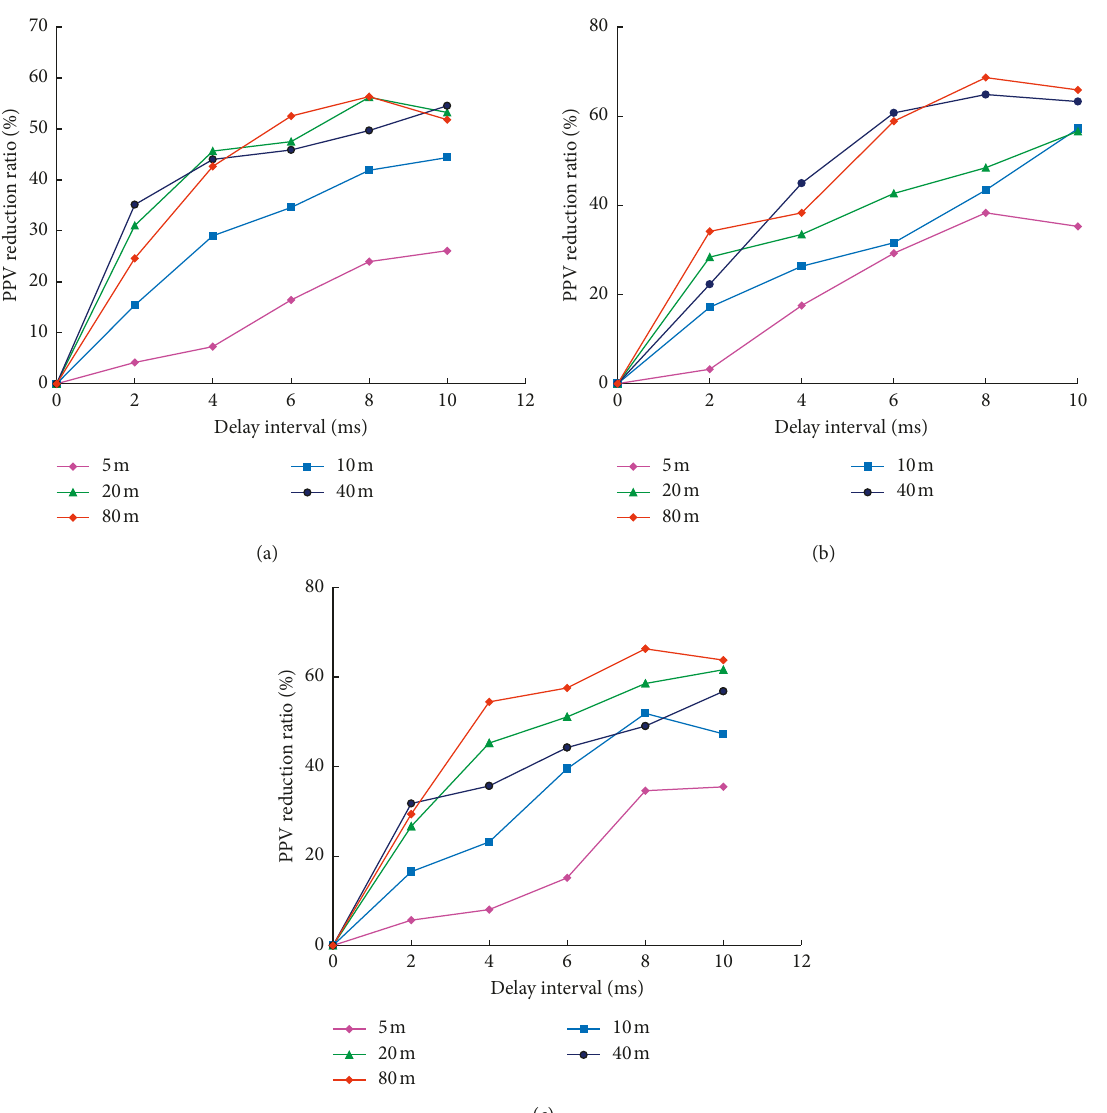
Figure 16: ARR of simultaneous blasting and delayed blasting. (a) X direction. (b) Y direction. (c) Z